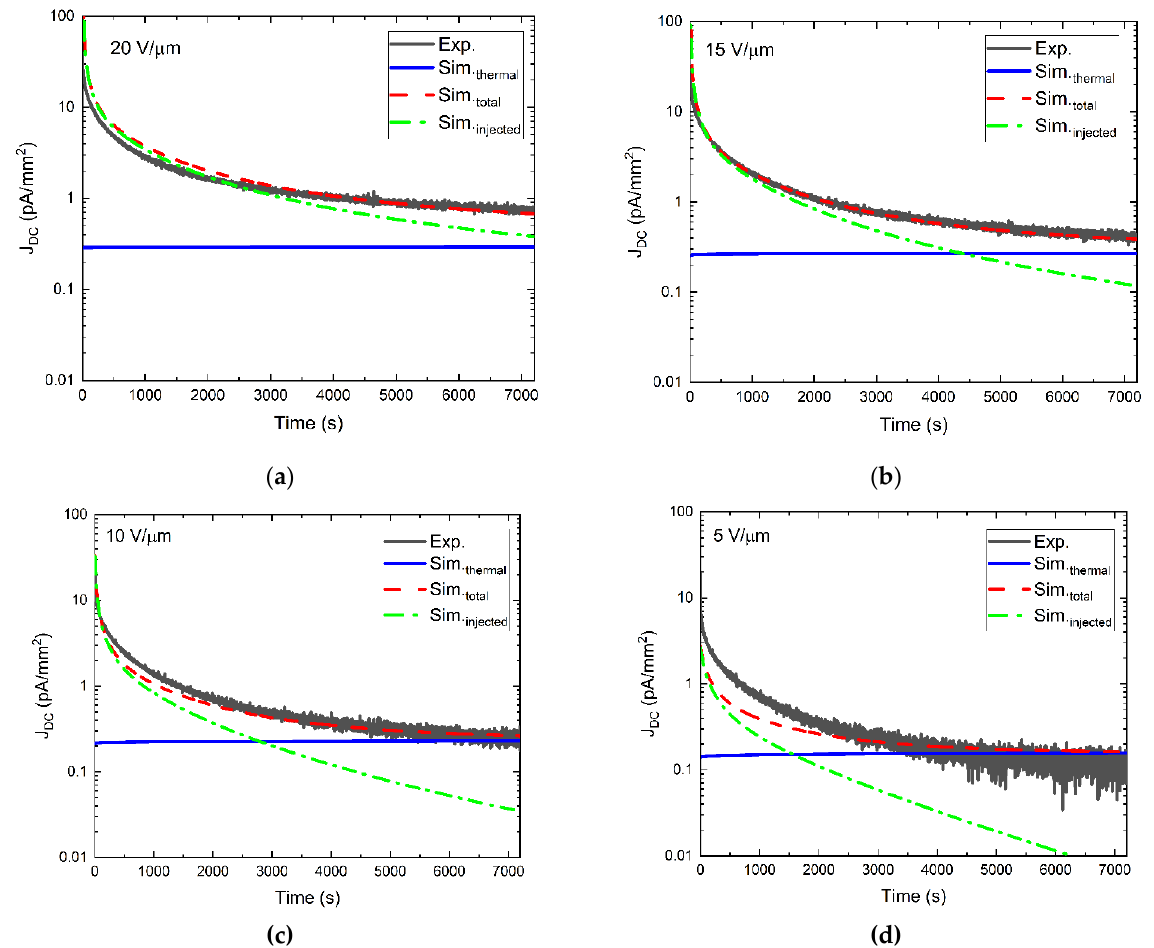
Figure 7. Experimental (solid black) and simulated (injected (dash-dotted green), thermal (solid blue), and total (dashed red)) DC kinetics data plotted in a semi-log scale corresponding to a PI/a-PbO detector biased at fields of ( a ) 20 V/ µ m, ( b ) 15 V/ µ m, ( c ) 10 V/ µ m, and ( d ) 5 V/ µ m for two